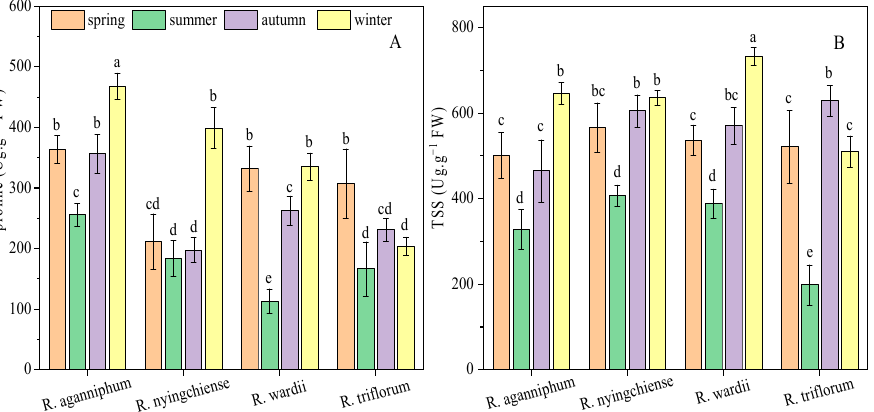
Figure 3. Osmotic adjustment substrates proline ( A ) and TSS ( B ) content of four Rhododendrons in different seasons under subalpine habitat on Sygera mountain of the QTP. Values are expressed as mean ± SE ( n = 9), and lowercase letters represent the significant differences among the four Rhodo- dendrons in four seasons ( p < 0.05).